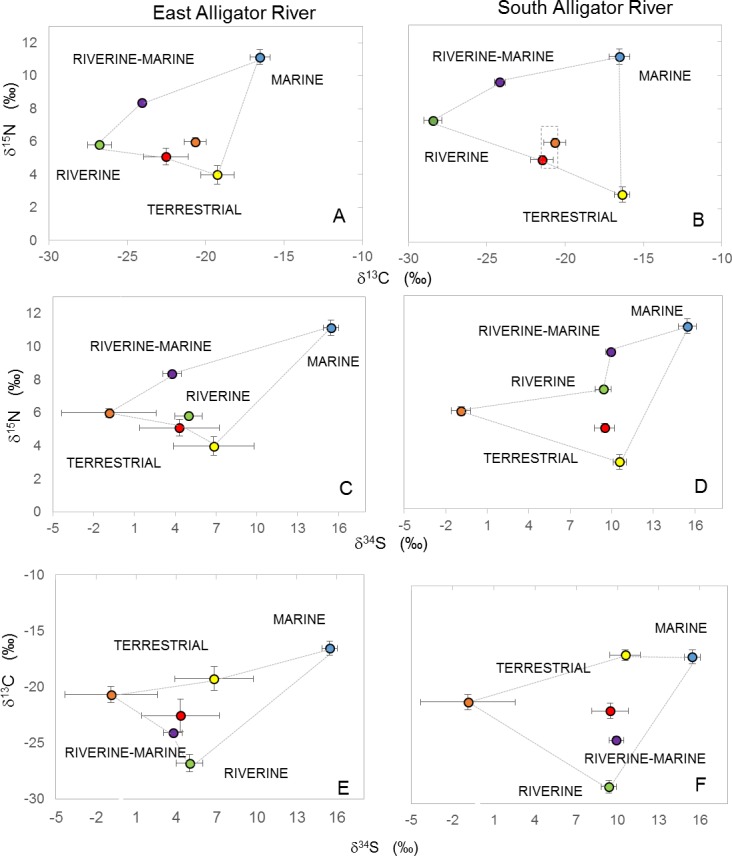
Isotopic composition (δ34S, δ13C and δ15N) of crocodiles (black diamonds) and potential prey.Samples were obtained fromthe East Alligator River (A,C, E) and South Alligator River (B,D,F), terrestrial prey includes water buffalo (orange circle), pigs (red circle) and wallabies (yellow circle); riverine is represented by mullet (green circle); riverine-marine prey is represented by barramundi (purple circle) and marine prey is represented by giant sea catfish (blue circle). Crocodile data were corrected to the level of prey by subtracting 1.4 ‰ from δ13C values [7]. The effect on the crocodile value of different fractionation factors is shown as a box of possible values around the crocodile mean in panel B.